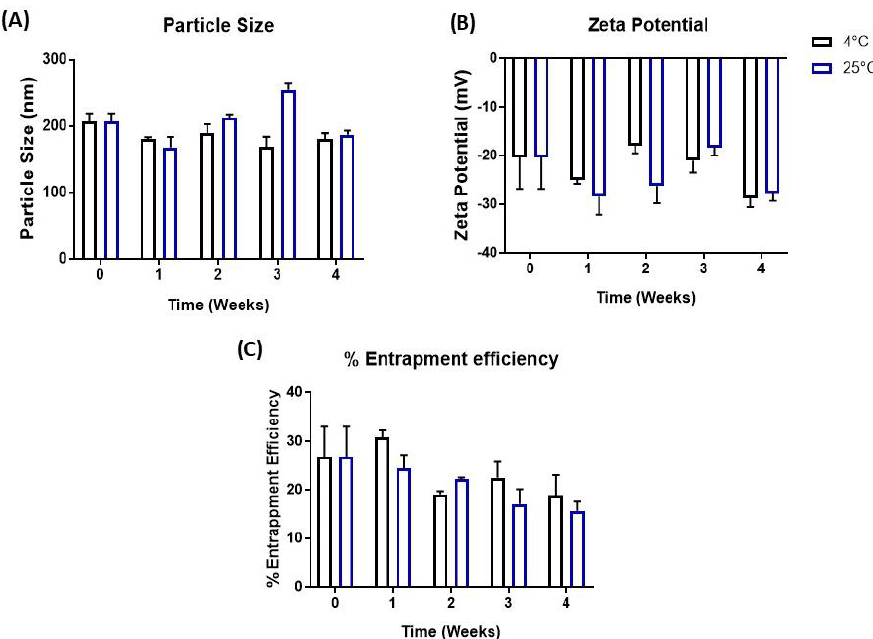
Figure 4. Influence of storage temperature and length of storage on ( A ) particle size, ( B ) zeta potential, and ( C ) % drug entrapment efficiency of FA-AQ NPs. Formulations were stored at 4°C and 25 °C over a period of 4 weeks. Data represent mean ± SD (n = 3).